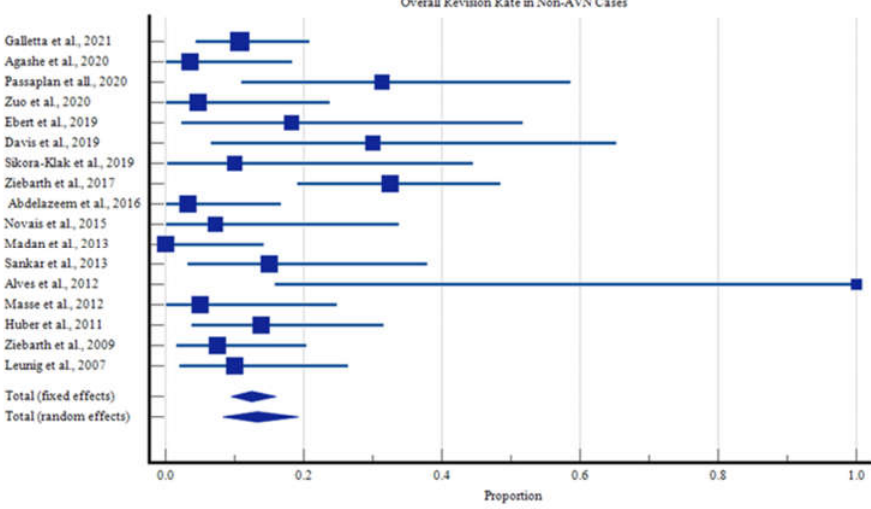
Figure 5. Overall Revision Rates for Reasons Other Than Avascular Necrosis.